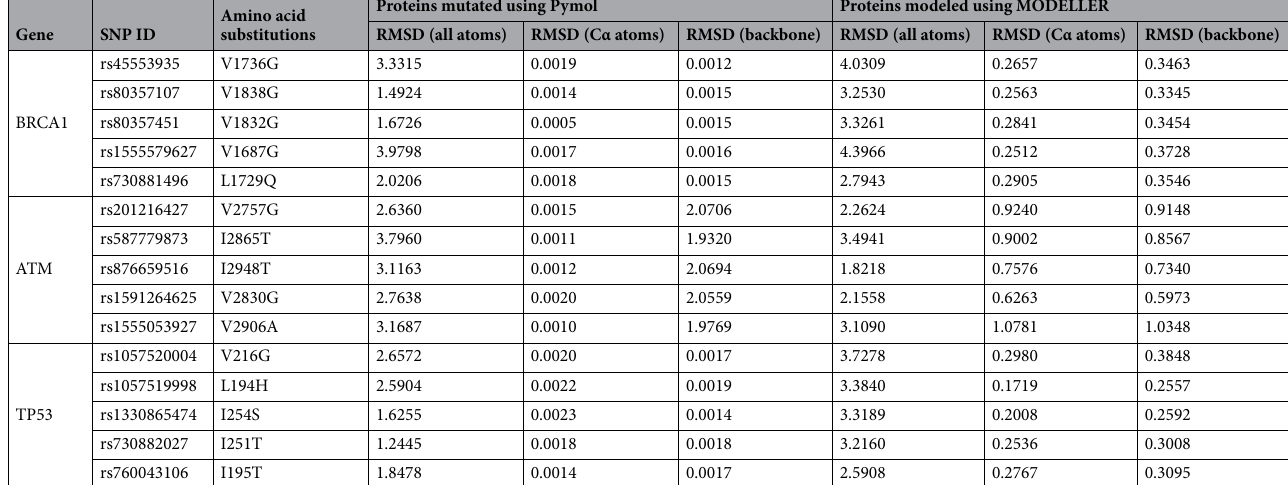
Proteins mutated using Pymol Proteins modeled using